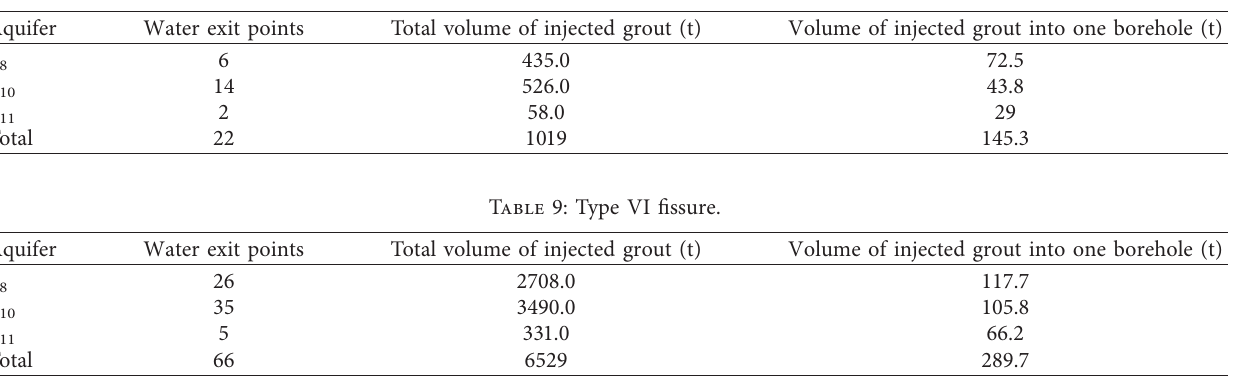
Table 8: Type V fissure.